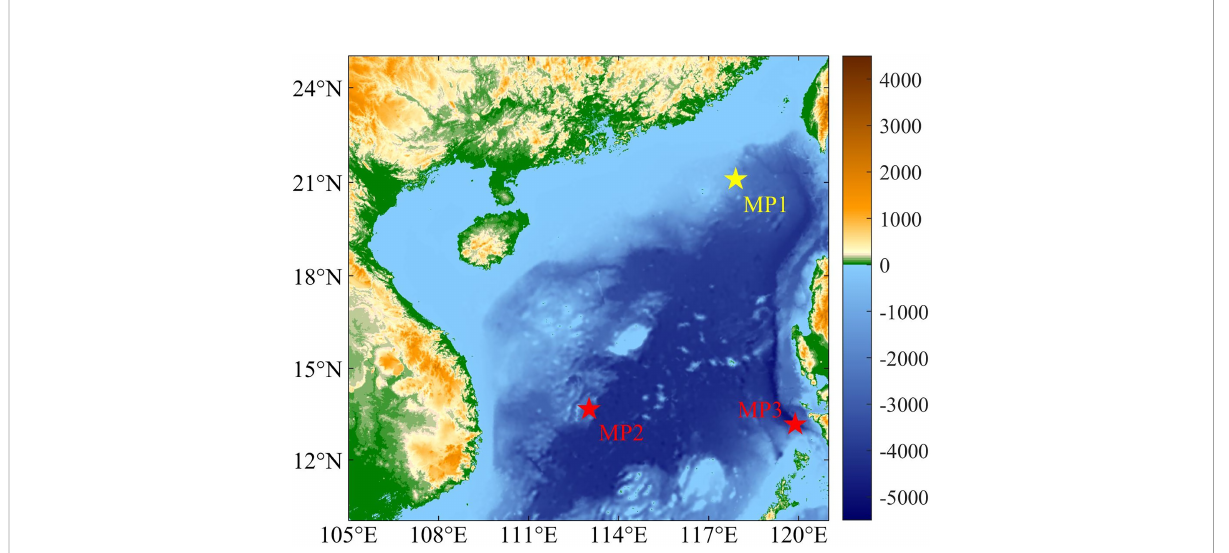
FIGURE 1 Topography and bathymetry of the SCS. The yellow star denotes the position of the mooring MP1 and two red stars denote two prescribed moorings of two ideal